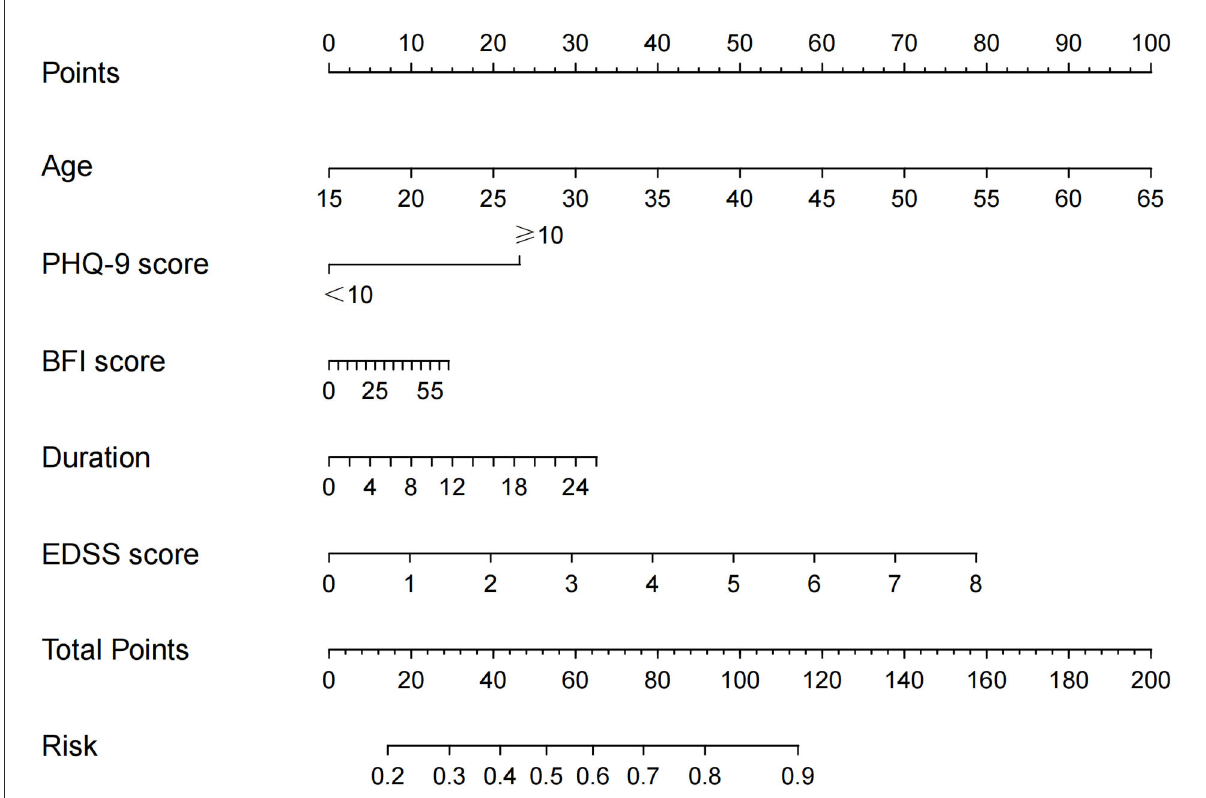
FIGURE2 A nomogram for predicting cognitive phenotypes in patients with NMOSD.